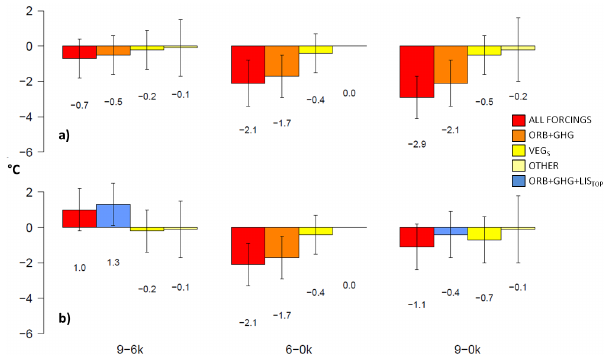
Figure 1. Simulated temperature change in the Arctic for (a) OG and (b) OGGIS equilibrium simulations, showing the relative con- tributions of different forcings; ORB + GHG (orbital and green- house gases), VEG S (vegetation changes in the Sahara), OTHER (other factors outside the Sahara region such as vegetation changes), ORB + GHG + LISTOPO (orbital and greenhouse gases and Lau- rentide Icesheet Topography, which is only relevant for the pe- riod 9–6ka) and ALL (for OG this includes GHG, ORB and pre- scribed Sahara vegetation; for OGGIS this includes GHG, ORB, prescribed Sahara vegetation, LIS melt, GIS melt and LIS topogra- phy changes). Error bars represent ± 1 σ .